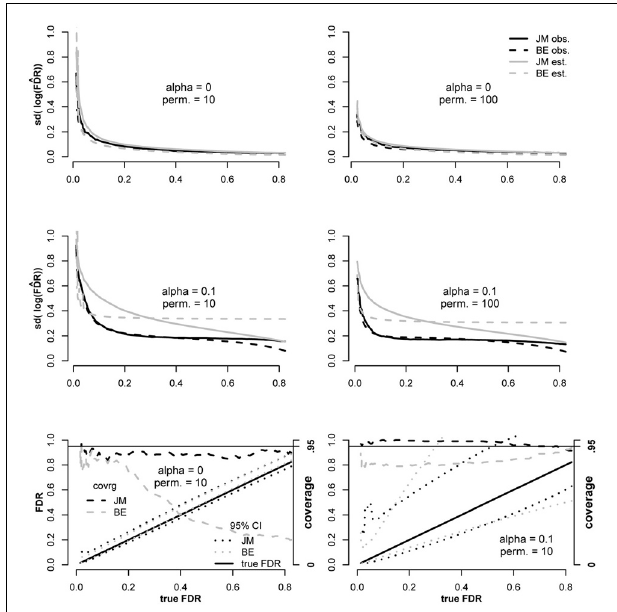
FIGURE 2 | Comparison of the Bradley Efron (2010a,b) estimator for variance of log(FDR) to the proposed estimator (JM) under independence among tests ( α = 0) and dependence ( α = 0.1). Coverage of derived 95% CI’s were also compared in the bottom plots according to Equation